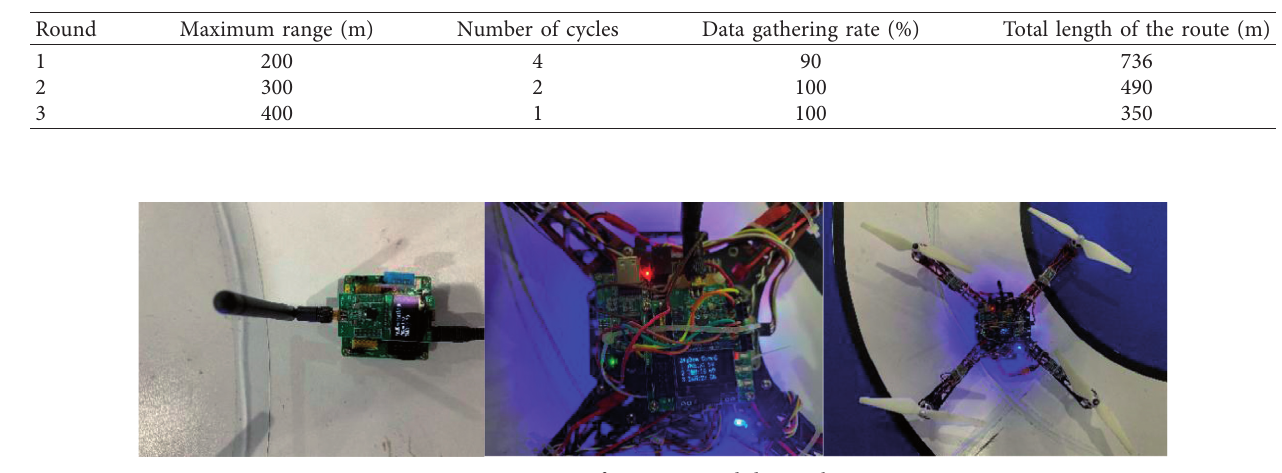
Table 2: Tour planning with different battery capacities.